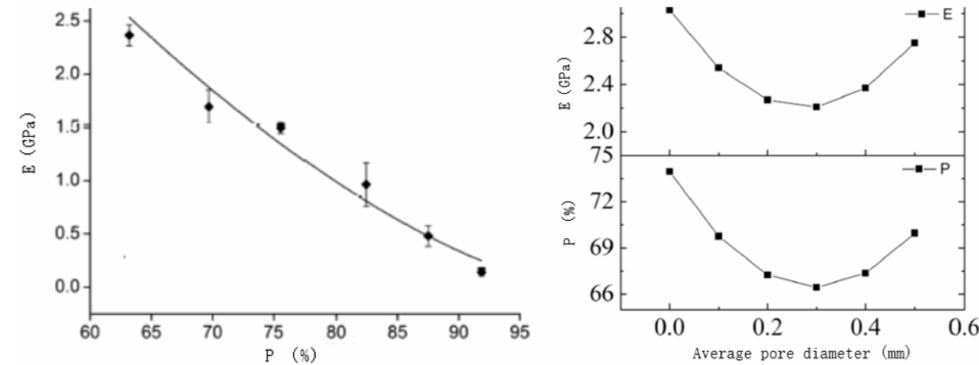
Figure 5. The relationship between the porosity and the apparent elastic modulus [18,19].